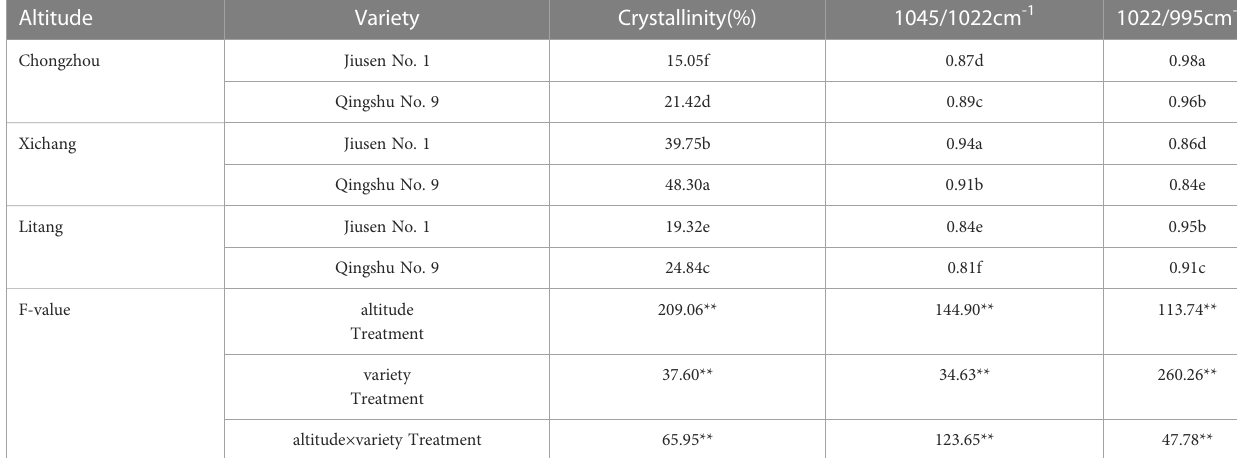
Different letters in the data in the same column represent the signi fi cance reaching 0.05; starch content is the percentage of dry weight; ** represents the signi fi cance level of